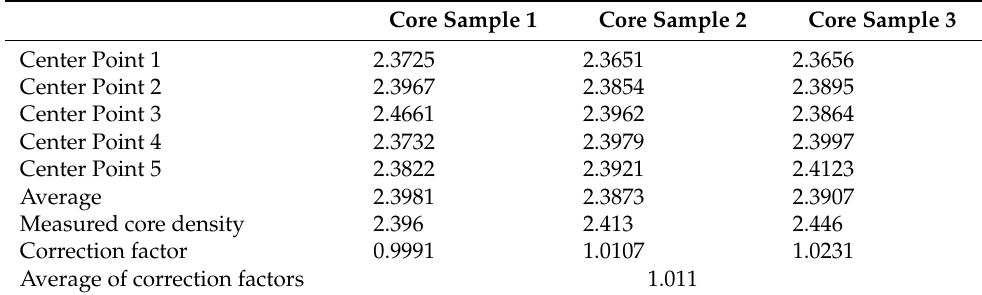
Table 6. PQI 380